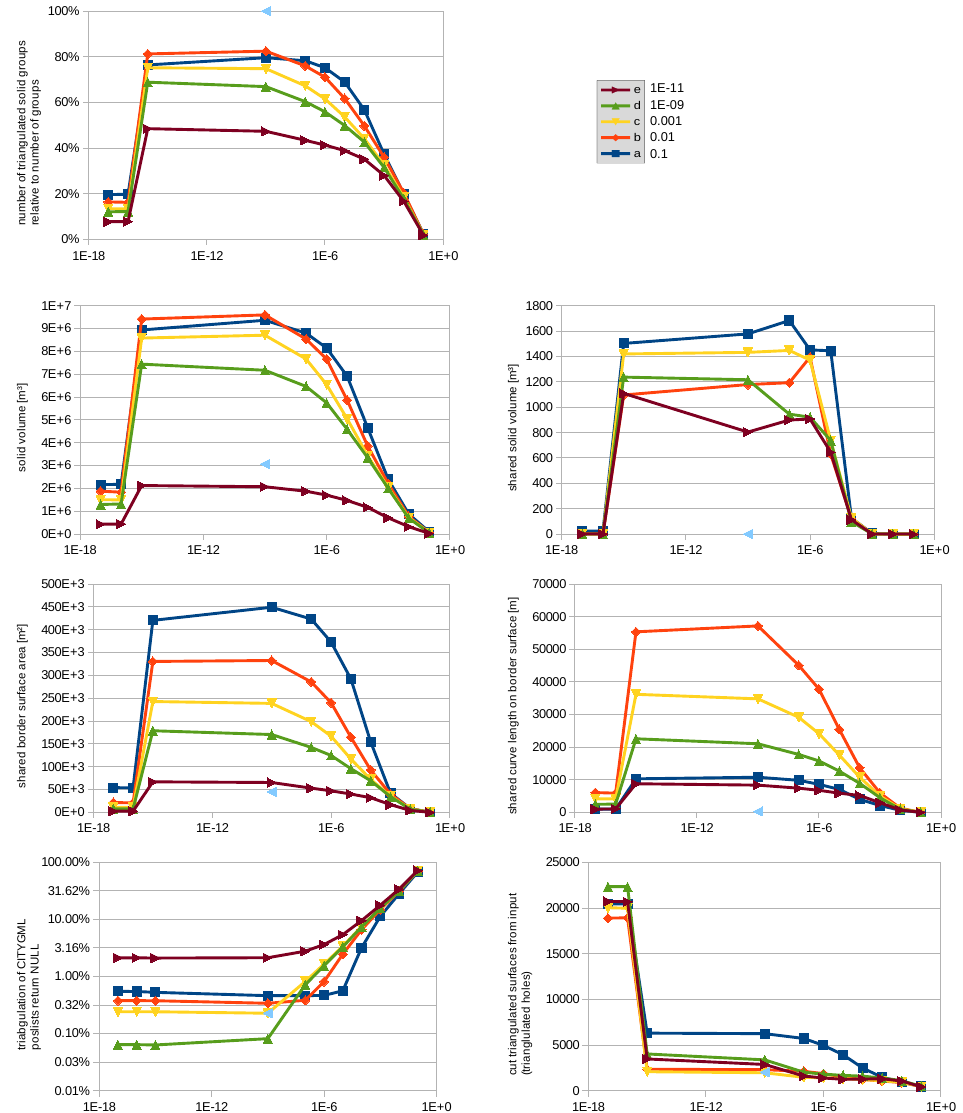
Figure 10. Results of city centre of Erfurt, third decomposition type. The dataset is decomposed into several groups, where each group consists of one building or one building part if a building consists of several building parts. ( x -axis: angular precision ζ , different colours for each precision (cid:101) = ε = σ = λ